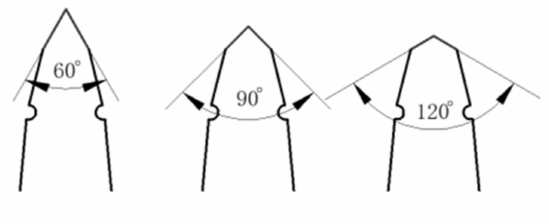
Figure 13. Local cavitation nose